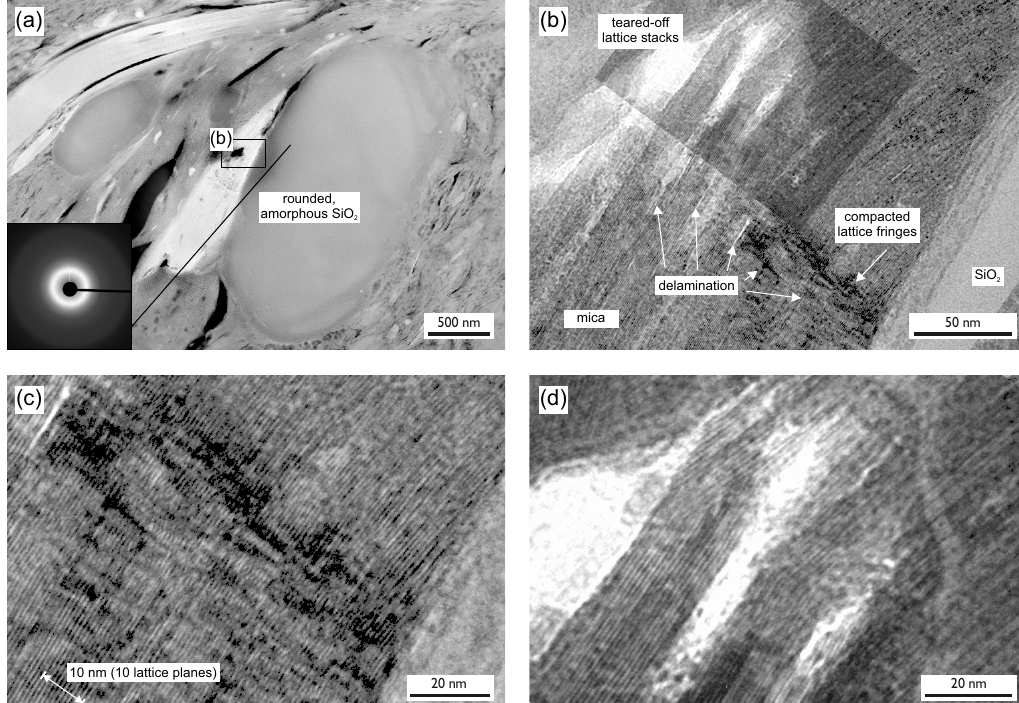
Figure 16. Microstructural details of gouge shown in Fig. 14 (sample V15-FIBgouge1). (a) TEM (HAADF) micrograph and selected area electron diffraction pattern of amorphous SiO 2 . (b, c, d) HR-TEM (BF) insets of panel (a) showing delamination and breakage of a mica(?) grain. See text for